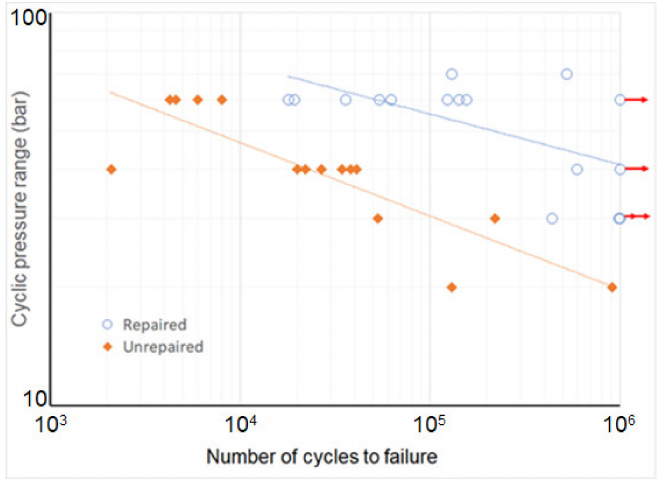
Figure 15. Comparison between repaired and unrepaired tests